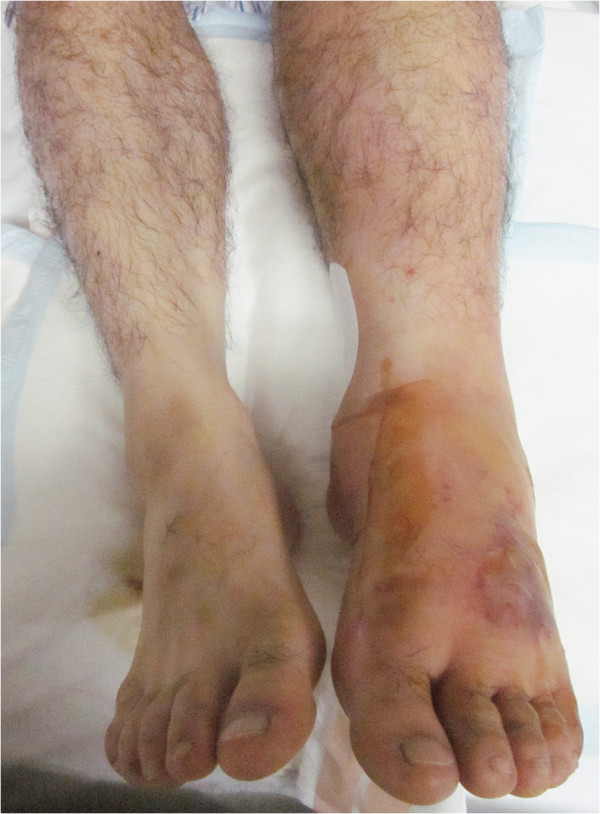
Clinical presentation on day 6.The patient experienced a burning sensation, tenderness, and redness in his left leg, from the upper part of his foot to his knee. Blisters are shown on the dorsum of the foot.